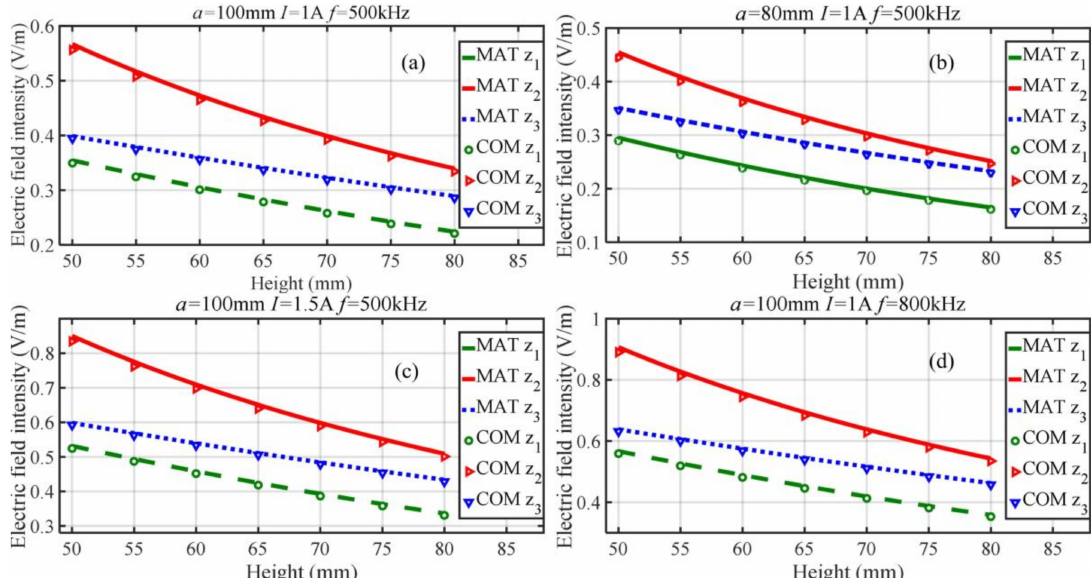
Figure 8. Electric-field intensity at different positions. ( a ) is the electric field curve when a = 100 mm, I = 1 A and f = 500 kHz, ( b ) is the electric field curve when a = 80 mm, I = 1 A and f = 500 kHz, ( c ) is the electric field curve when a = 100 mm, I = 1.5 A and f = 500 kHz, ( d) is the electric field curve when a = 100 mm, I = 1 A and f = 800